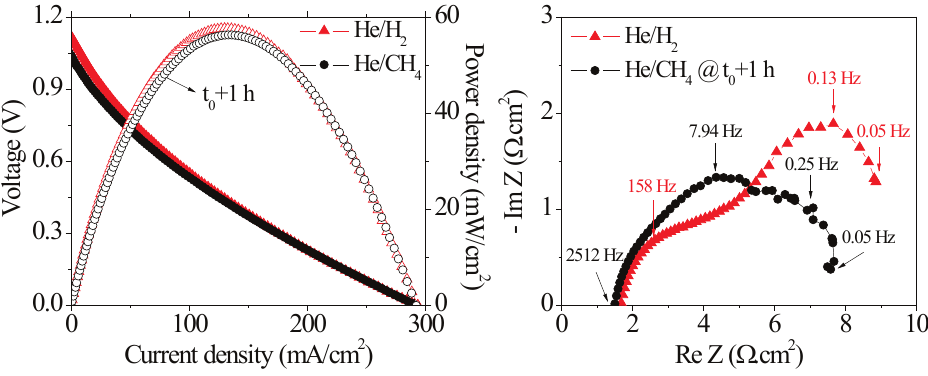
Figure 2. V–I curves and Nyquist plots of impedance spectra for the Ni/YSZ anode fuel cell tested at 750 °C in He/H (100 sccm, 50 vol% H 2 Impedance spectra were recorded at open circuit voltage (OCV) with frequency range of 10 6 –0.05 Hz. t is the time at which He/H 0 stabilized ZrO . 2